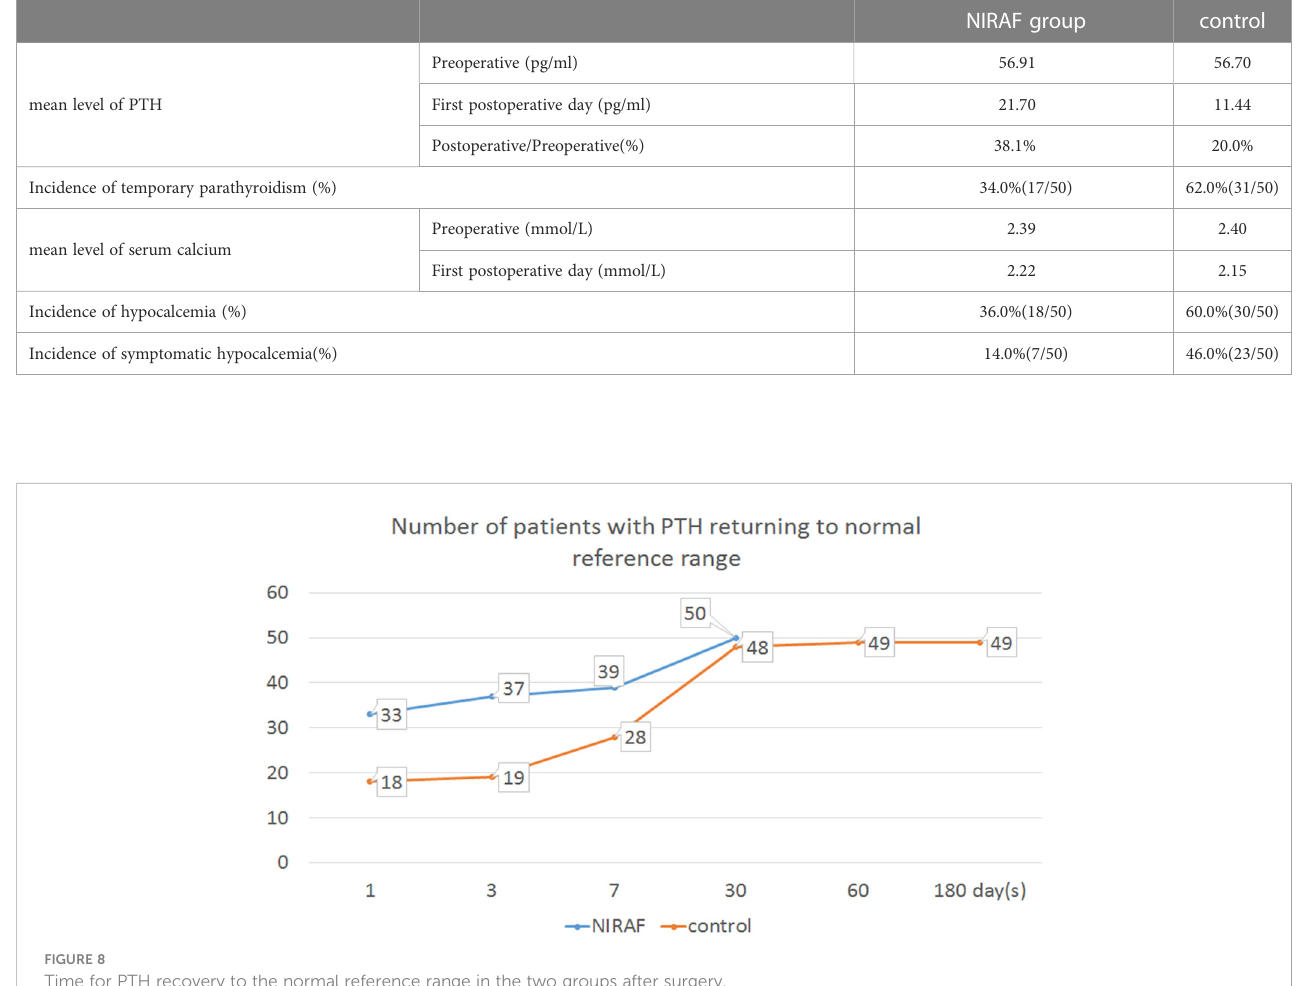
TABLE 3 Levels of parathyroid hormone and blood calcium before and after